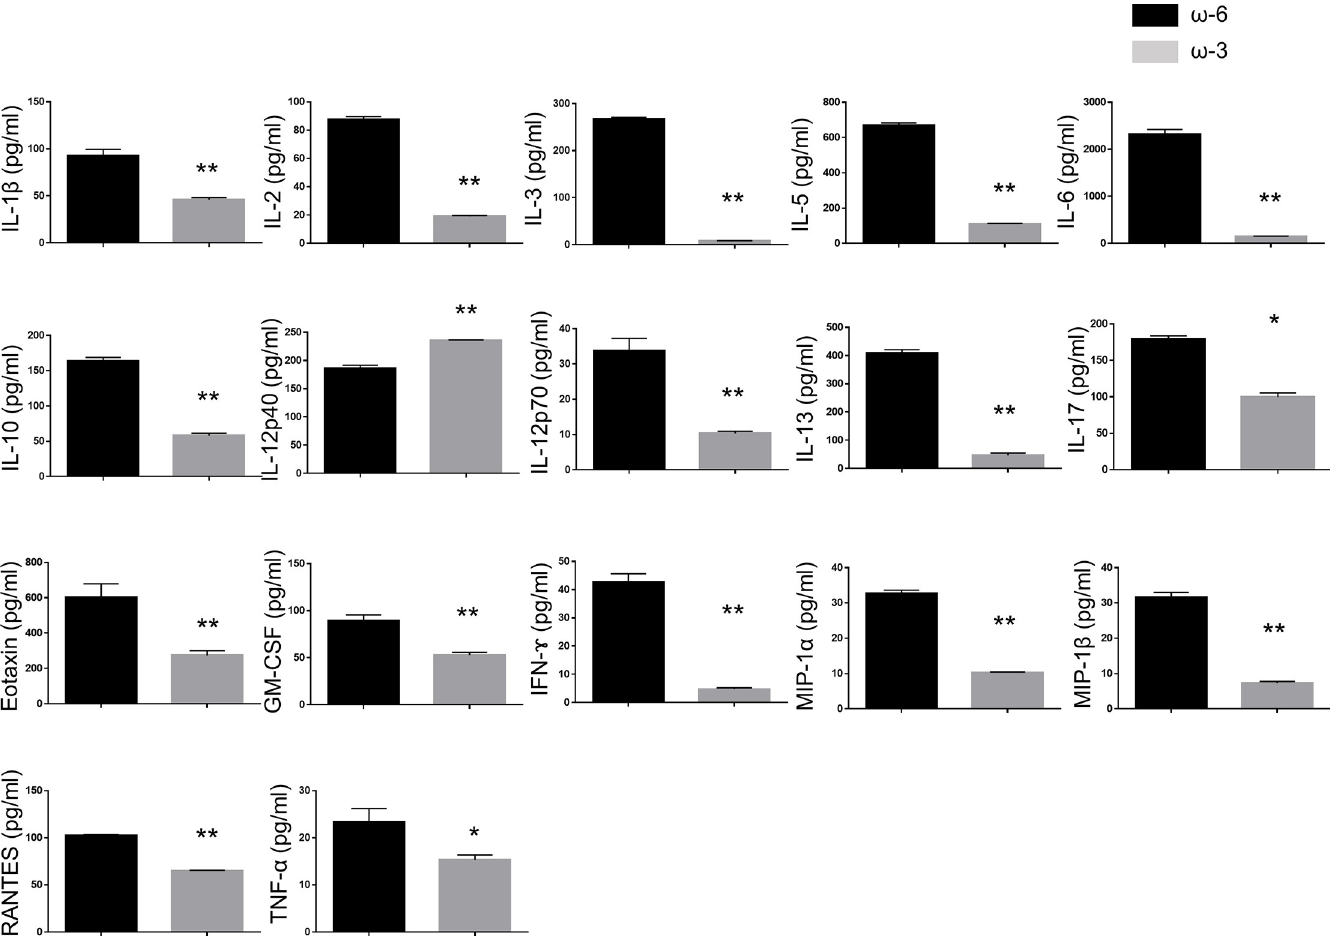
Fig 4. Cytokine production by T cells isolated from EAU mice after adoptive transfer of DCs from ω -3 LCPUFA–fed mice. CD4 + T cells isolated from EAU mice at 10 days after the adoptive transfer of DCs from mice fed a diet containing ω -3 ( n = 5) or ω -6 ( n = 5) LCPUFAs (17 days after disease induction) were cultured for 24 h, after which the concentrations of the indicated cytokines in the culture supernatants were determined with a multiplex assay. Data are means + SEM for four EAU mice per group. � P < 0.05, �� P < 0.01 versus the ω -6 LCPUFA diet (Mann-Whitney U